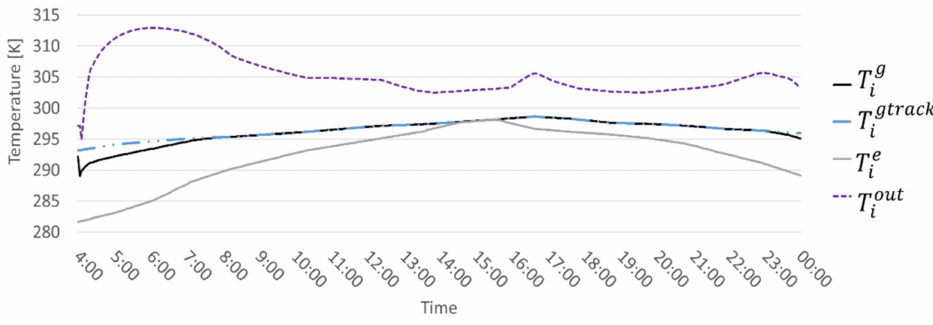
Figure 3. Input and state variables associated with the temperature in the MPC approach.